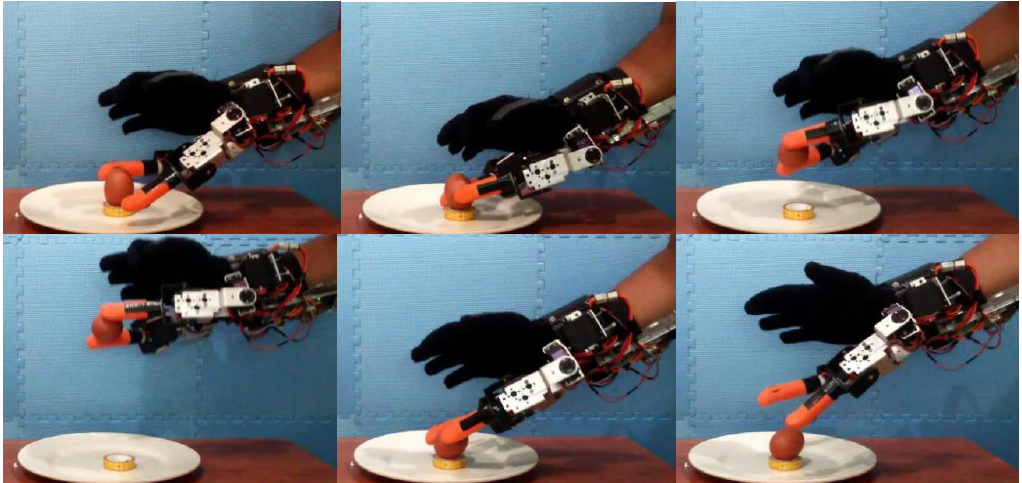
Figure 12. Sequence images of haptic performance test.